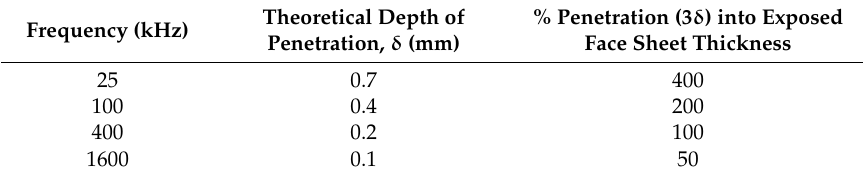
Table 2. Depth of penetration analysis.